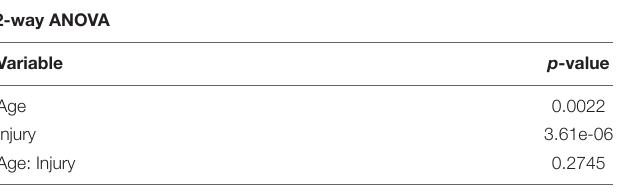
TABLE 1 | Results of 2-way ANOVA tests for significant effects of age and injury on the number of muSCs in the myotome.